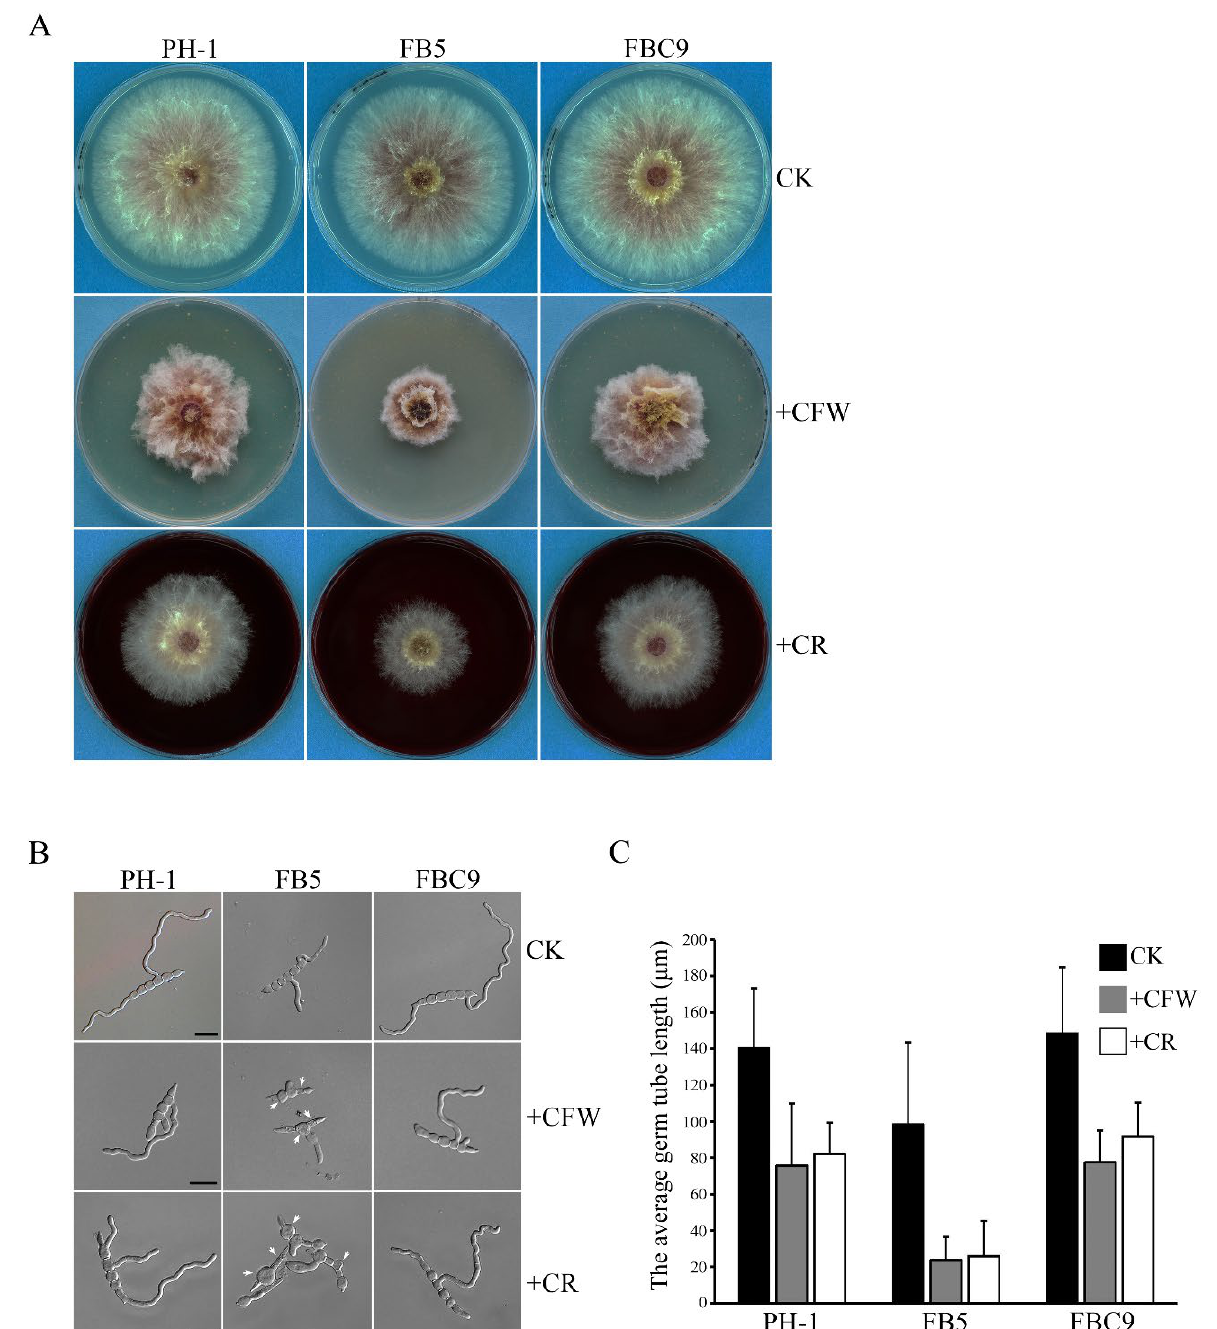
Figure 4. The involvement of FgBni4 in response to cell wall stresses in F. graminearum . ( A ) Colonies of wild-type strain (PH-1), Fgbni4 mutant (FB5), and Fgbni4 / FgBNI4 complemented transformant (FBC9) grew on PDA plates supplemented without (CK) or with 200 µ g/mL CFW or 300 µ g/mL CR for 3 days. ( B ) Conidia of indicated strains were incubated in YEPD without (CK) or with 20 µ g/mL CFW or 15 µ g/mL CR for 6 h before examination. White arrows point to the swollen or ruptured cells of Fgbni4 mutant. Bar, 20 µ m. ( C ) Hyphae length of indicated strains without (CK) or with CFW or CR treatments. The length of hyphae was measured by using Image J software.